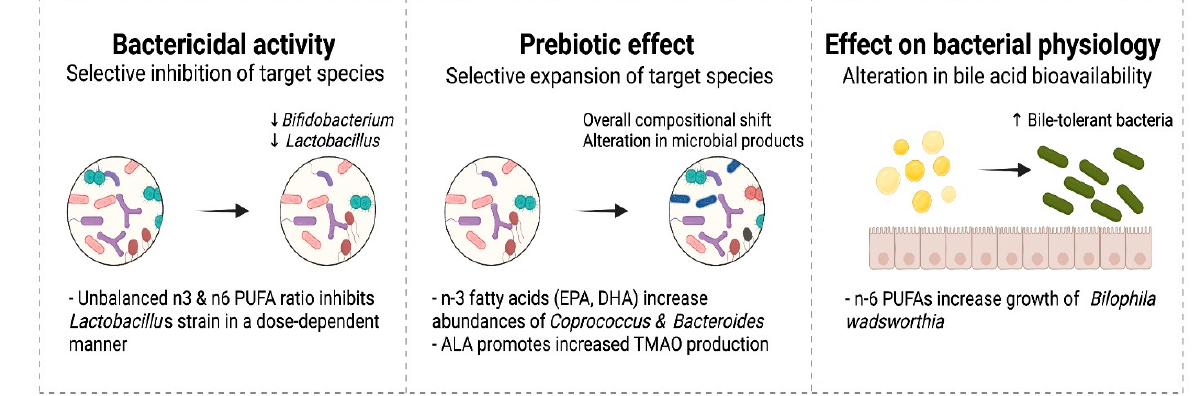
Figure 3. Effect of dietary fatty acids on the gut microbiome.